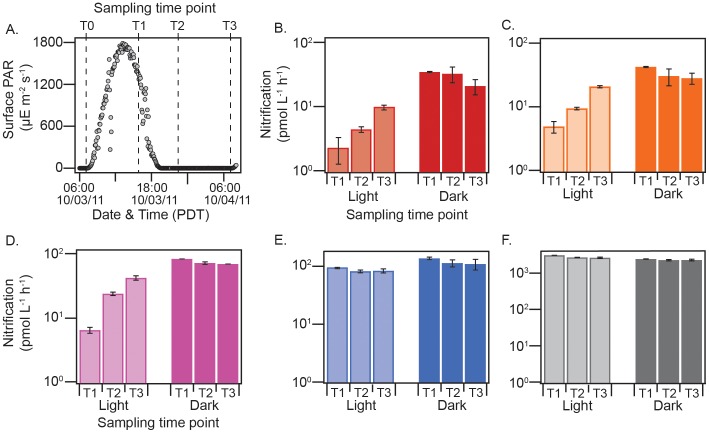
Results of diel periodicity experiments showing nitrification rates from five depths in the photic zone at station 67–70, incubated under in situ light conditions or in complete darkness for 24 h.(A) Surface photosynthetically active radiation (sPAR) during the experiment, with sampling intervals denoted by vertical hashed lines; (B) rates of nitrification at each sampling interval in surface waters (2 m) held at 90% sPAR or in the darkness; (C) from 5 m and held at 50% sPAR or in the dark; (D) from 10 m and held at 15% sPAR or in the dark; (E) from 20 m and held at 1% sPAR or in the dark; (F) and from 35 m and held at 0.1% sPAR or in the dark. Incubations were conducted in October of 2011 at station 67–70 in the Northeast Pacific. Error bars denote the standard deviation about the mean of duplicate samples.